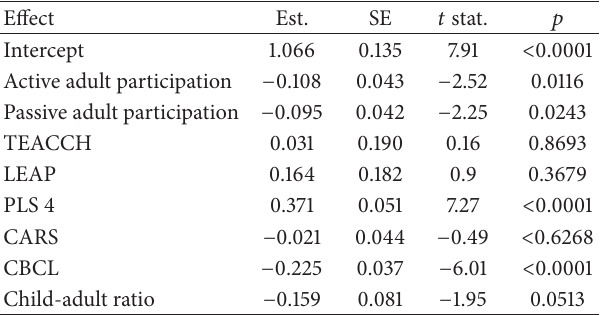
Table 4: Model one results for associations between child engage- ment and adult participation.